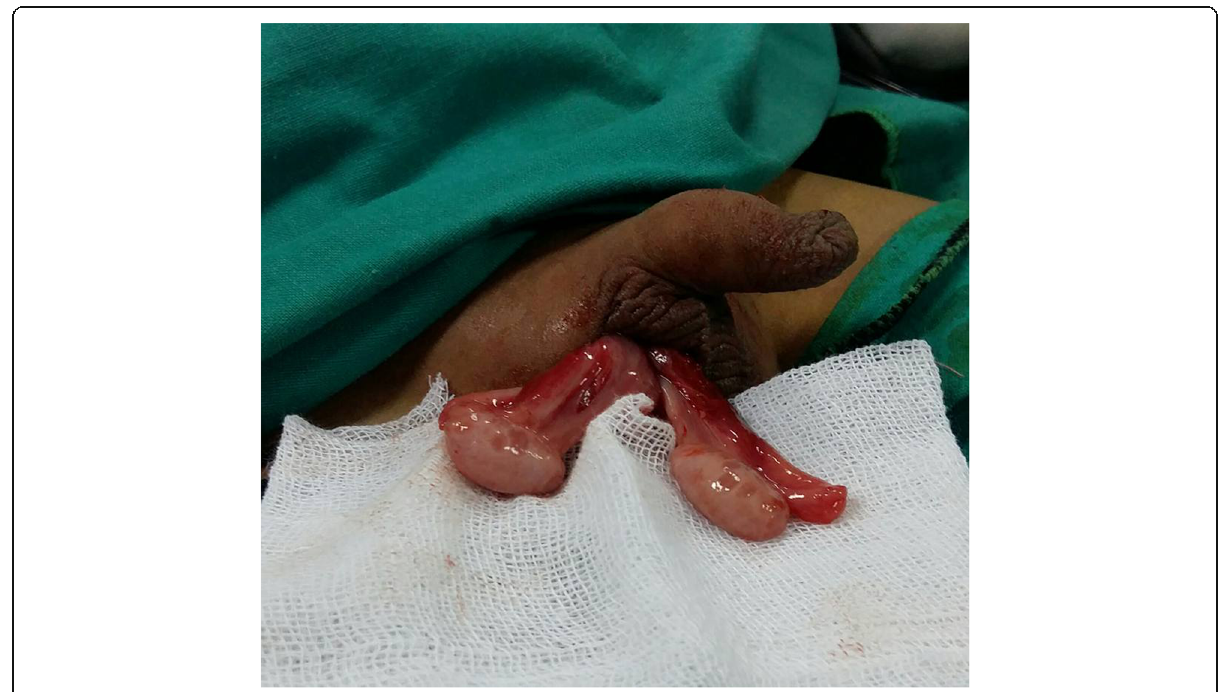
Fig. 2 A 5-year-old boy presented with empty left hemiscrotum due to transverse testicular ectopia which was diagnosed preoperatively by ultrasonography with congenital hernia. A view before scrotal positioning and transseptal orchiopexy. Note the average size of both testes and adequate length of spermatic